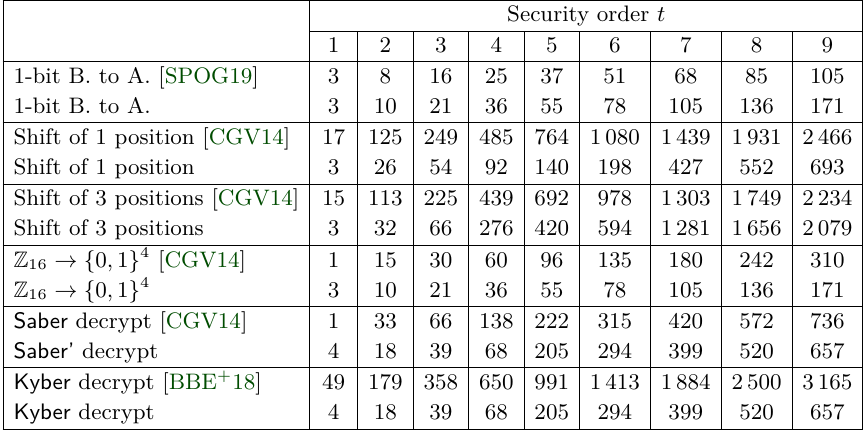
Table 16: Number of 32-bit random elements needed for one execution of each